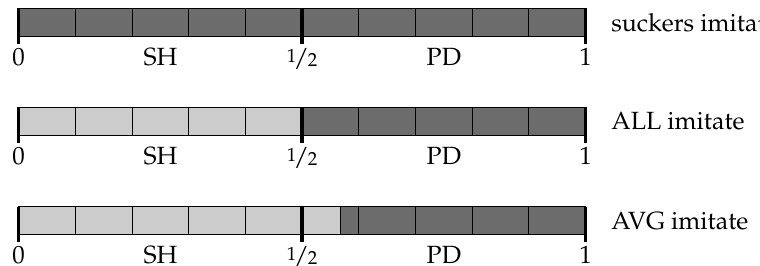
Figure 3. Categorization thresholds that determine where to cooperate (light gray) and defect (dark gray) over a space of stag hunt games (SH, < 1 / 2 ) and prisoners’ dilemmas (PD, > 1 / 2